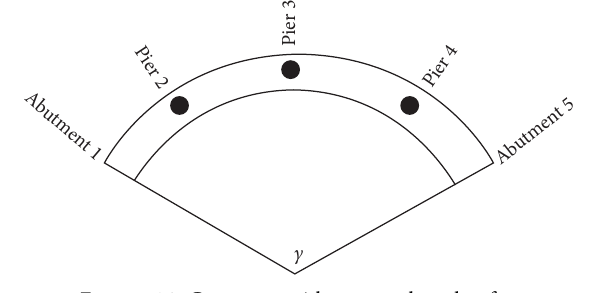
Figure 14: Curvature with a central angle of c Table 7: Guideline for calculating α .